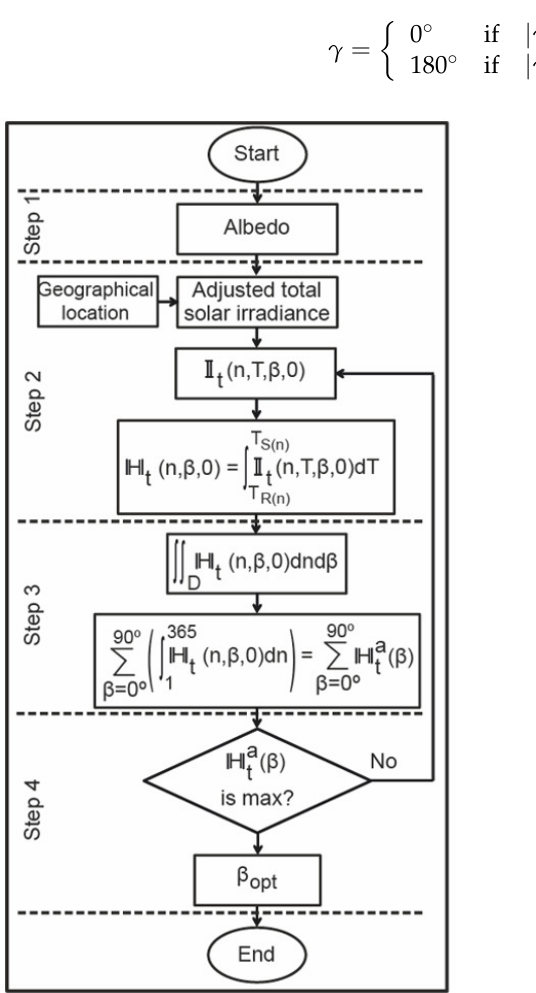
Figure 4. A flowchart outlining the proposed methodology.